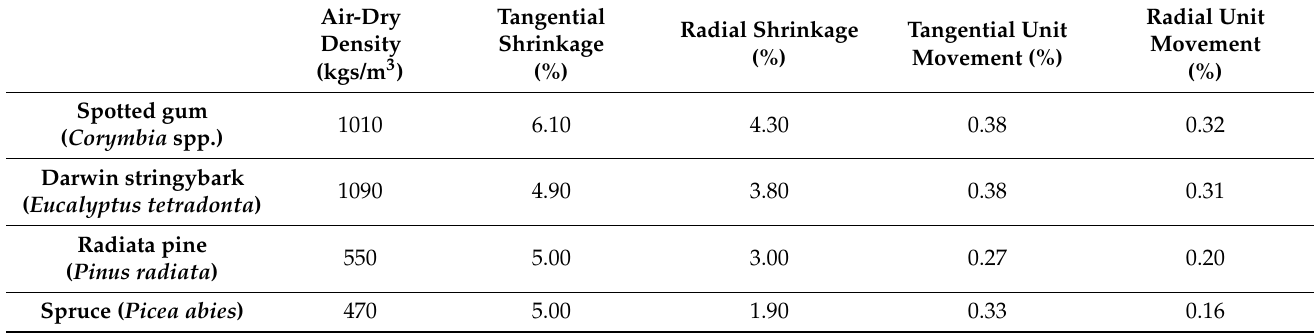
Table 1. Comparison of shrinkage and unit movement 1 between different timbers used for glulam 2